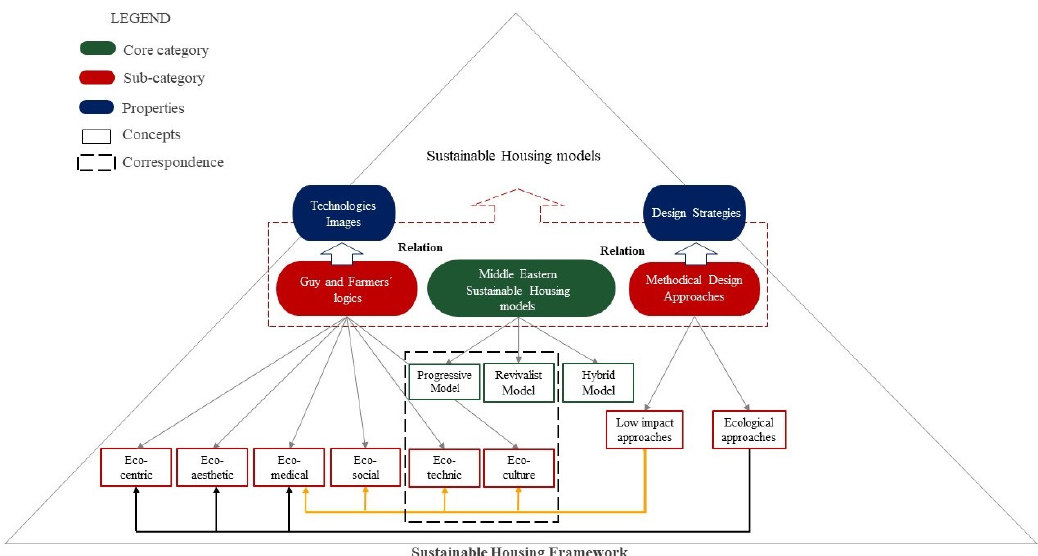
Figure 3. Grounded theory methodology used in the study.